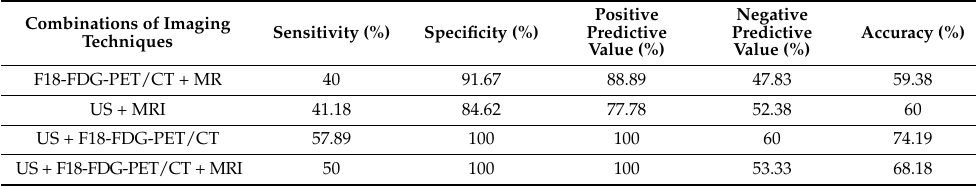
Table 4. Specificity, sensitivity, and negative and positive predictive values of combinations of imaging techniques for evaluating complete axillary response after neoadjuvant chemotherapy. Combinations of Imaging